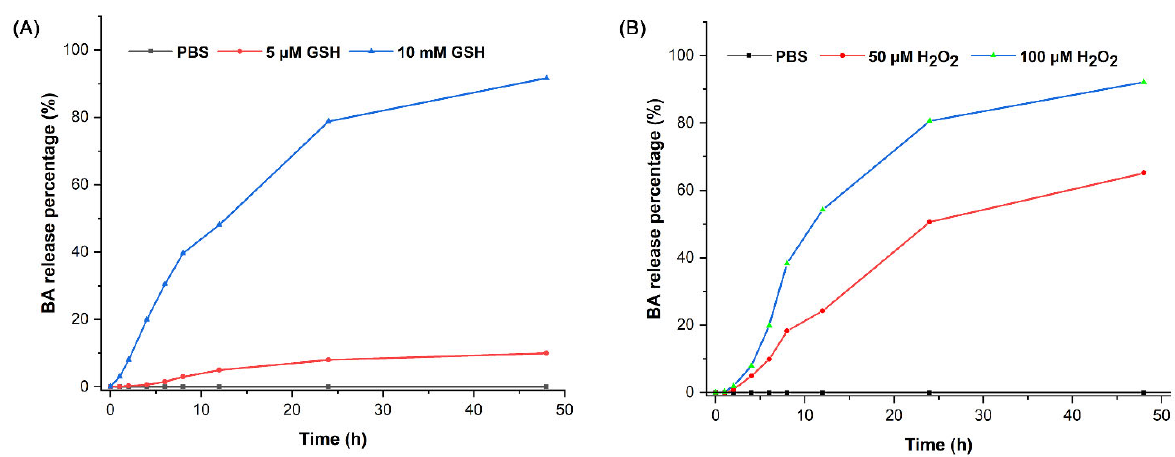
Figure 2. BA release profiles from the GOx@BNPs (50 µ M) with various concentrations of ( A ) GSH and ( B ) H 2 O 2 were determined via HPLC.